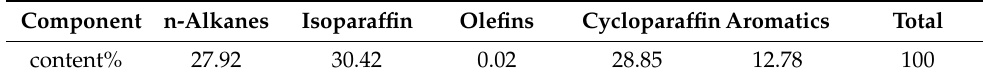
Table 1. Contents of components in naphtha [35].